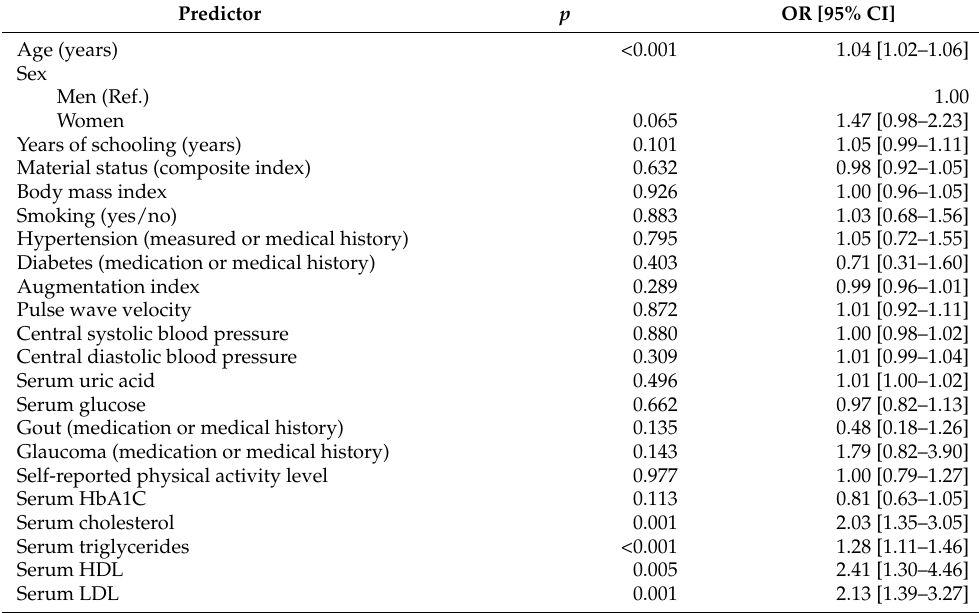
Table 1. The adjusted odds ratios for the conventional risk factors for AMD, logistic regression, with odds ratios (OR) and 95% confidence intervals (CI).